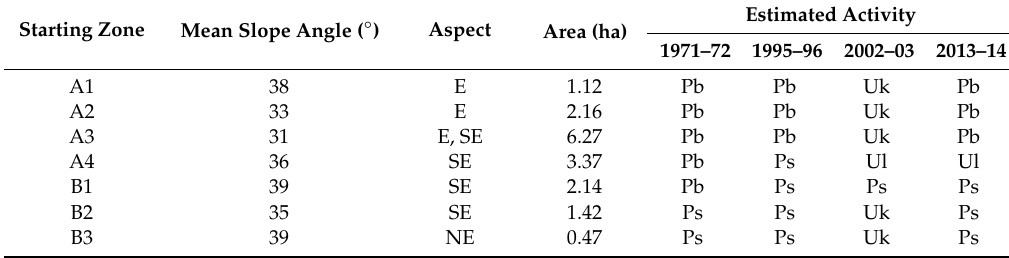
Table 2. Main characteristics of the identified release areas, and synthesis of their activity inferred from the damage observed on vegetation. Pb: Probable; Ps: Possible; Ul: Unlikely; Uk: